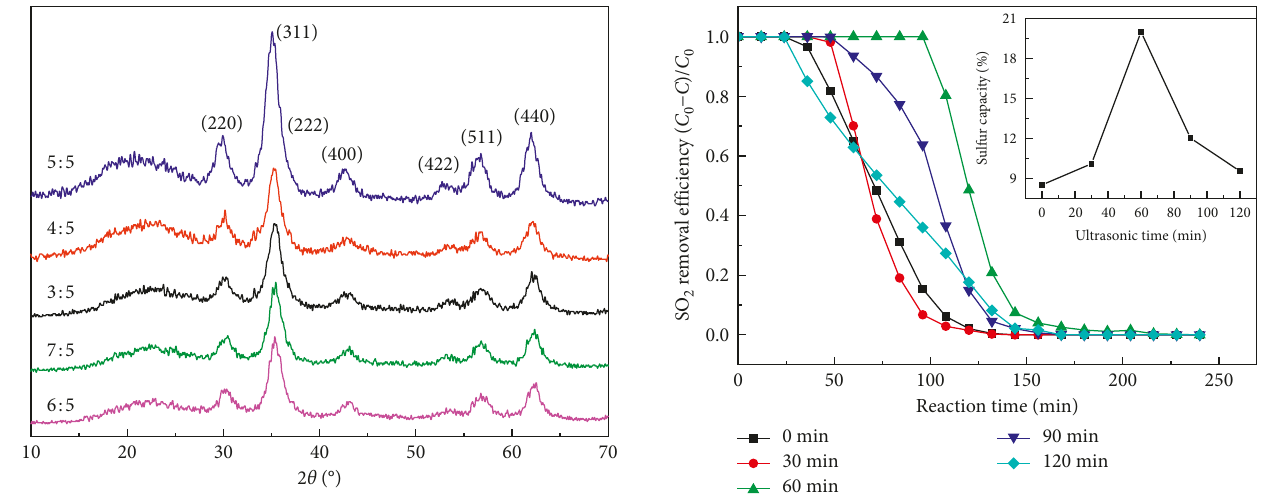
Figure 4: Effect of zinc ferrite/activated carbon at different ul- trasonic time periods on desulfurization